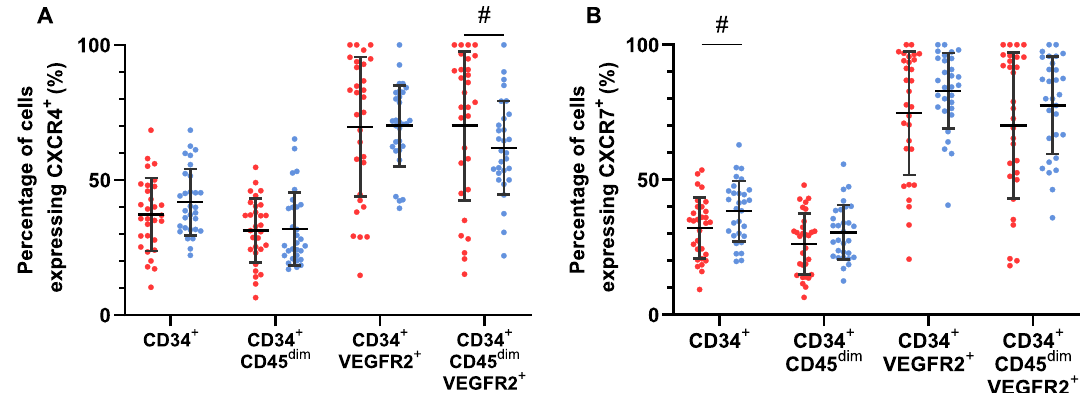
Figure 3. The percentage of CD34 + , CD34 + CD45 dim HPCs and CD34 + VEGFR2 + , CD34 + CD45 dim VEGFR2 + EPCs expressing CXCR4 + ( A ) and CXCR7 + ( B ) between the type 1 diabetes (red circles) and non-diabetes (blue circles) groups. #—signifies significant difference between the type 1 diabetes and non-diabetes groups. Data shown are mean ±